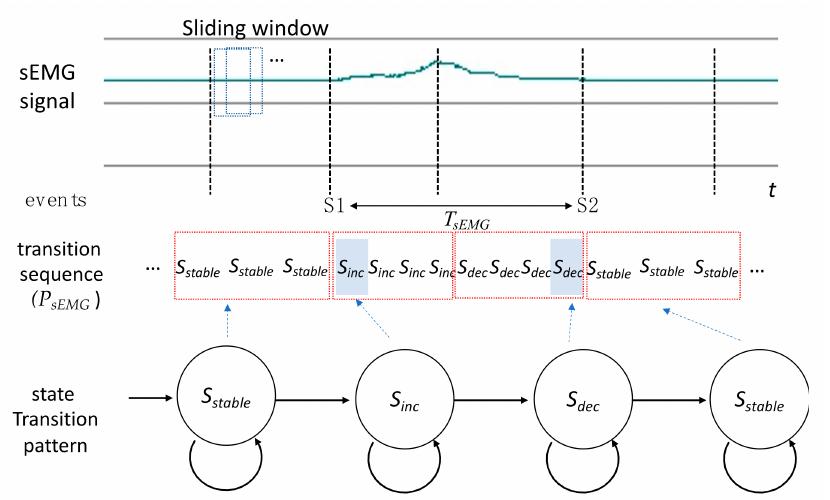
Figure 7. Example of the identification process of a state transition pattern in the surface electromyo- graphy (sEMG) transition sequence.